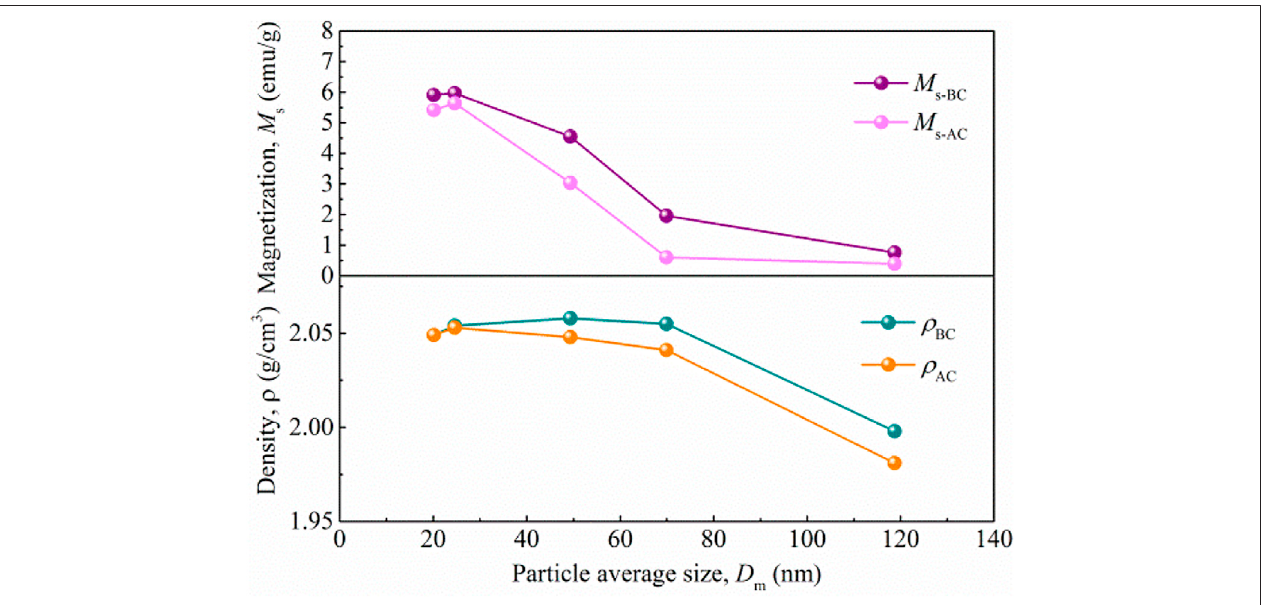
FIGURE6| AveragesizesoftheFe 3 O 4 nanoparticlesdependenceofthemagnetization,densityandthestabilityofthemagneticnano fl uids.ThesubscriptsACand BC represent the samples before and after centrifuging, respectively.